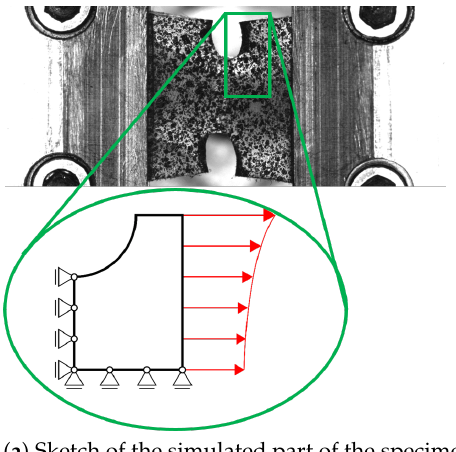
using symmetry properties of the sample. experimental to the simulated material response for the initial guess and the final parameter set including two variations. The shown displacement is taken from the bottom node of the right boundary in the symmetry plane. Figure 7. ( a ) Sketch of the chosen segment of the specimen with the applied boundary conditions. ( b ) Comparison of the load-displacement curves of the experiment with the results of the initial parameter set, the optimised Parameter Sets #1 ( n iso = 1.0), #2 ( n iso = 0.9), and #3 ( n iso =